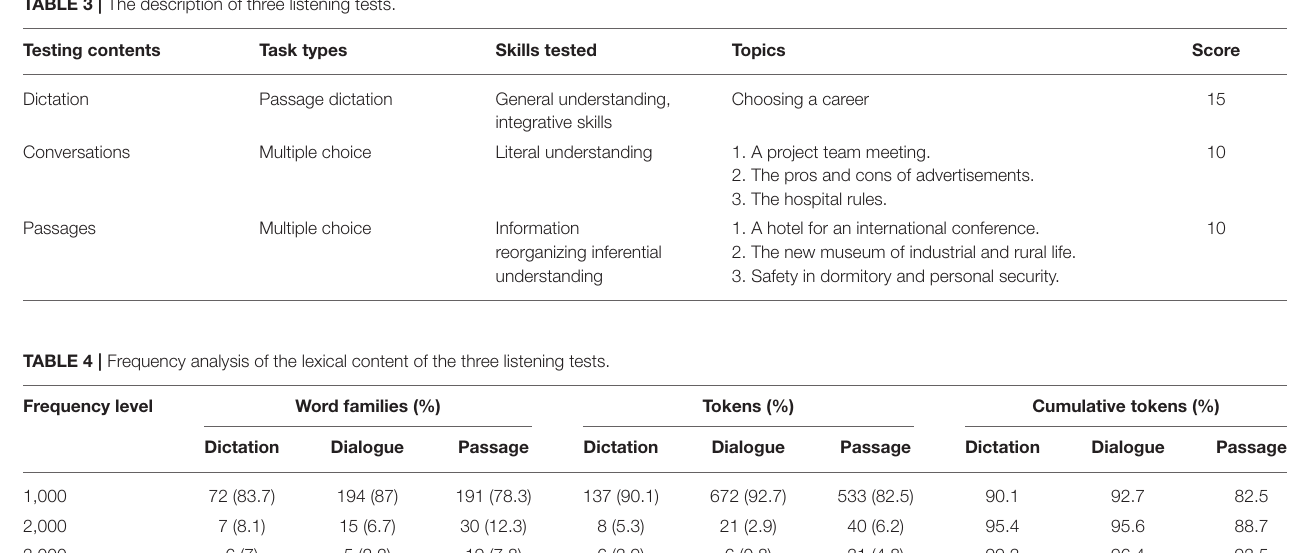
TABLE 3 | The description of three listening tests.